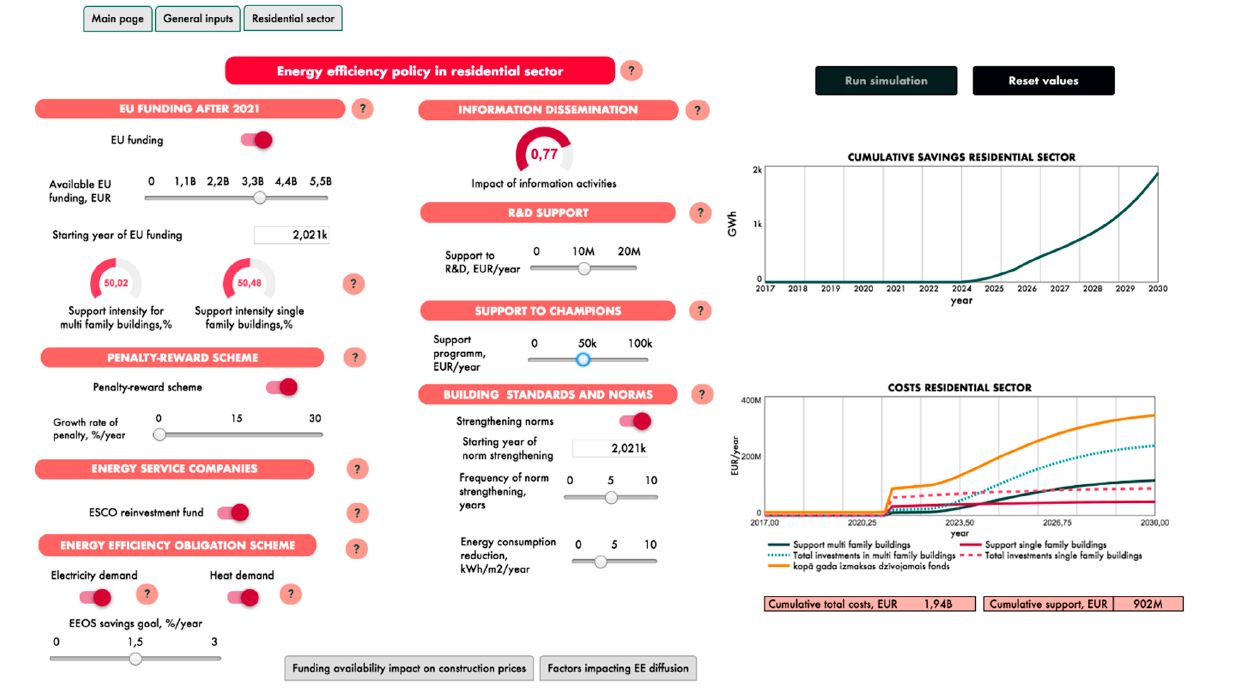
Figure 11. The first layer of Internet-based model interface for selection of policy tools.